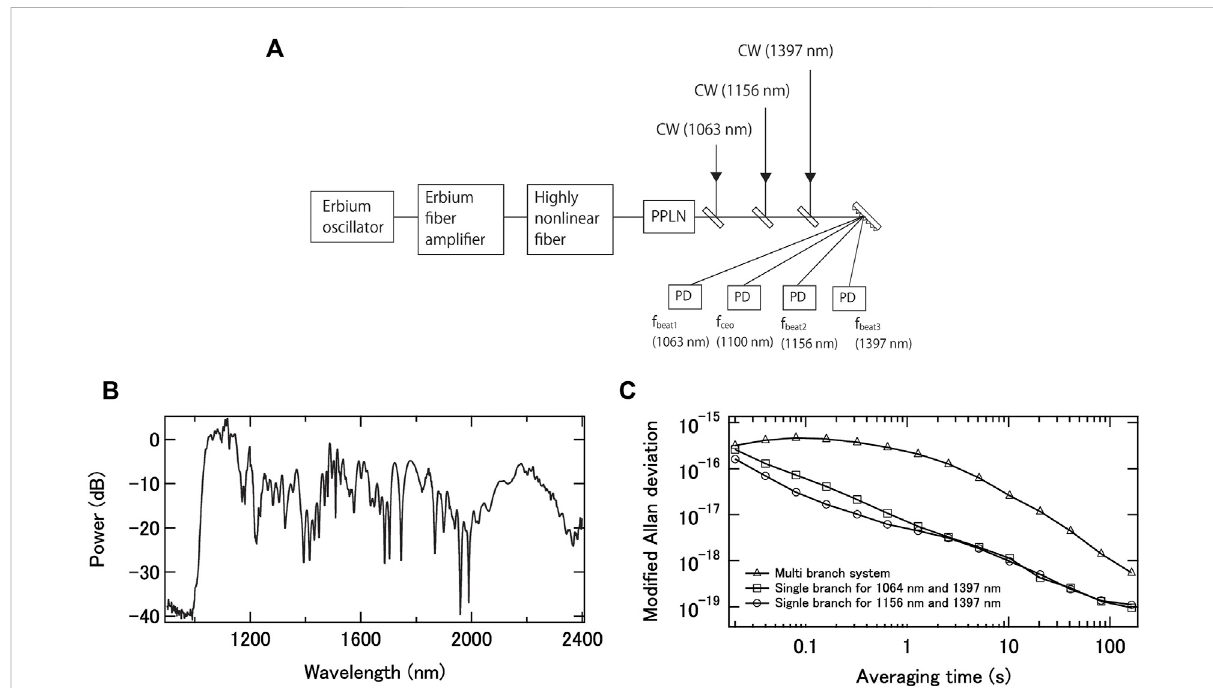
FIGURE 4 (A) Experimental set up for a single-branch frequency-comb system as used for optical-clock comparison adapted from ref. 32; PPLN = periodically poled lithium niobate; PD = photodiode. (B) Optical spectrum of supercontinuum generation from an Er-doped fi ber optical frequency